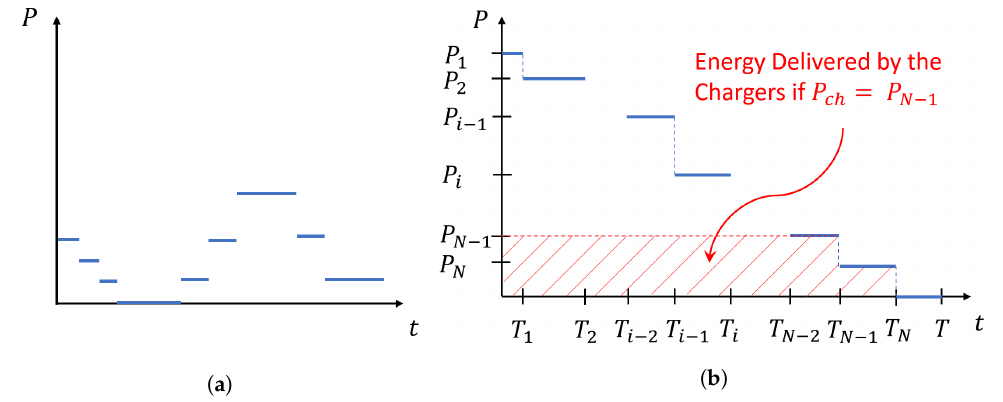
Figure 7. ( a ) The power demand from the chargers as a function of time. ( b ) The power demand distribution. Notice that the right-hand side shows the schematically sorted power demand over the entire service life of the chargers, whereas the left-hand side shows the unsorted demand over a shorter